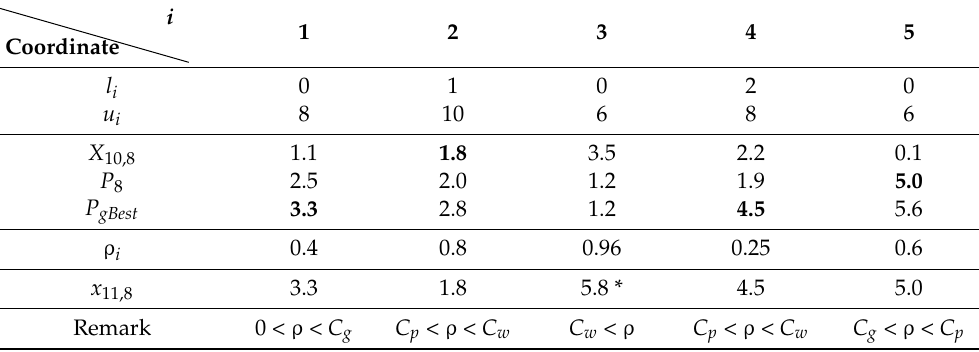
Table 2. An example of simplified swarm optimization (SSO)